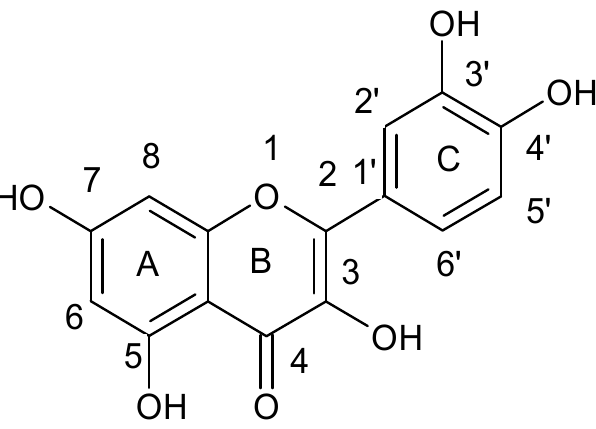
Figure 5. Chemical structure of quercetin.